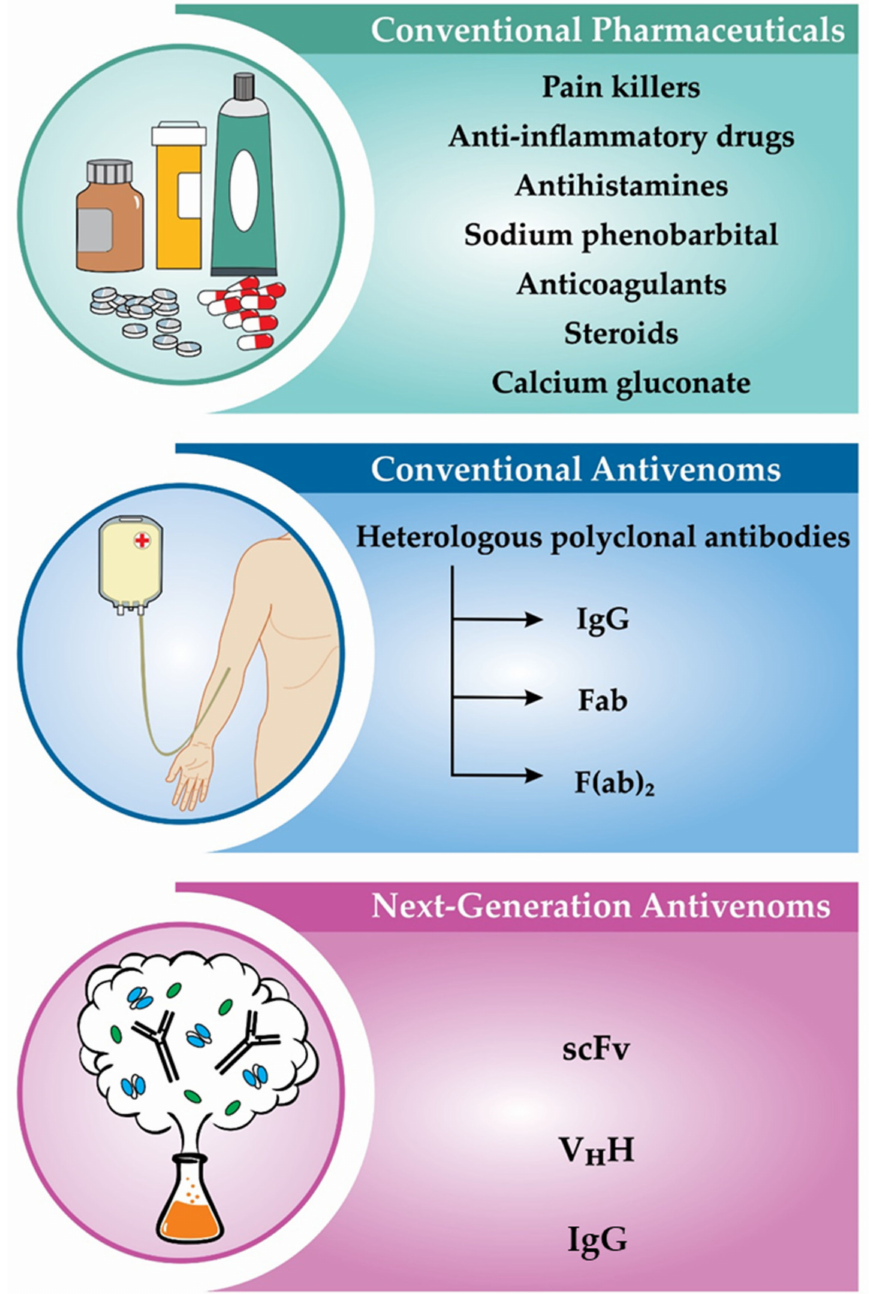
Figure 3. Scorpion envenoming treatments. Conventional pharmaceuticals are used for mild envenomings, while antivenom therapy is applied in moderate and severe cases. Recombinant antivenoms are suggested to have higher therapeutic value over the conventional antivenoms and may become the future mainstay of